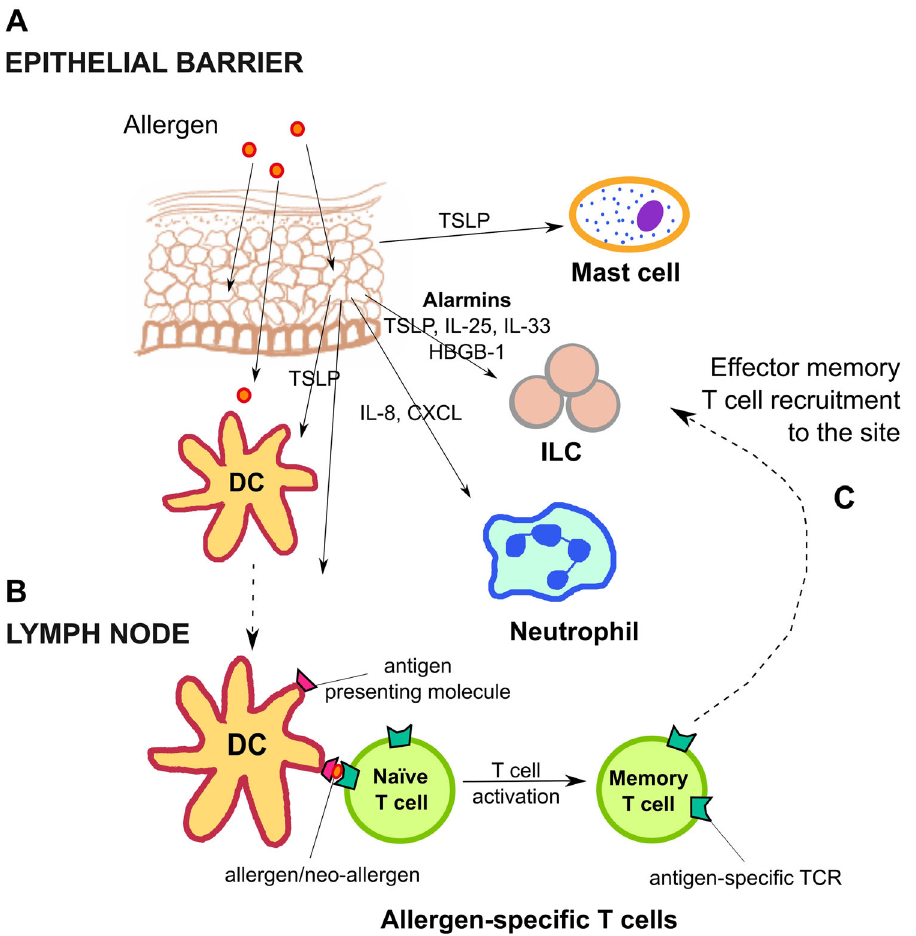
Fig. 1 Antigen penetration through epithelial barrier and allergen